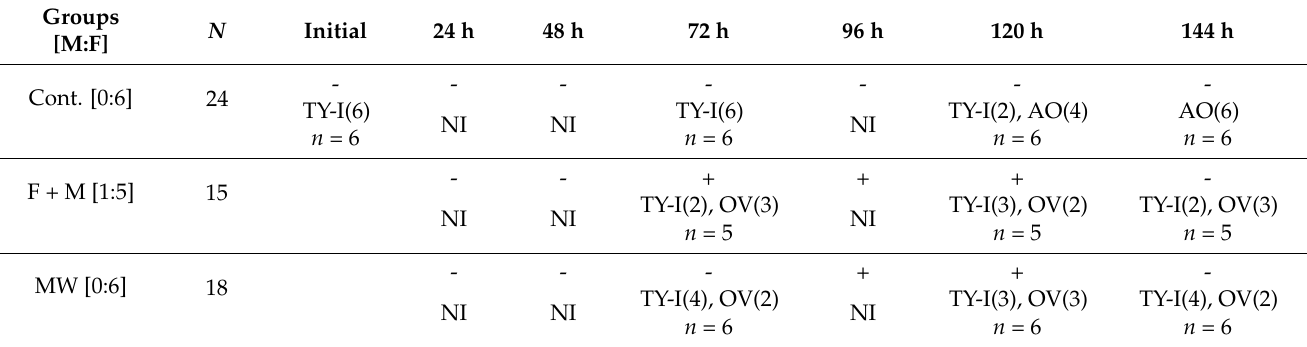
Table 2. Egg collection in rearing tanks and oocyte stages in